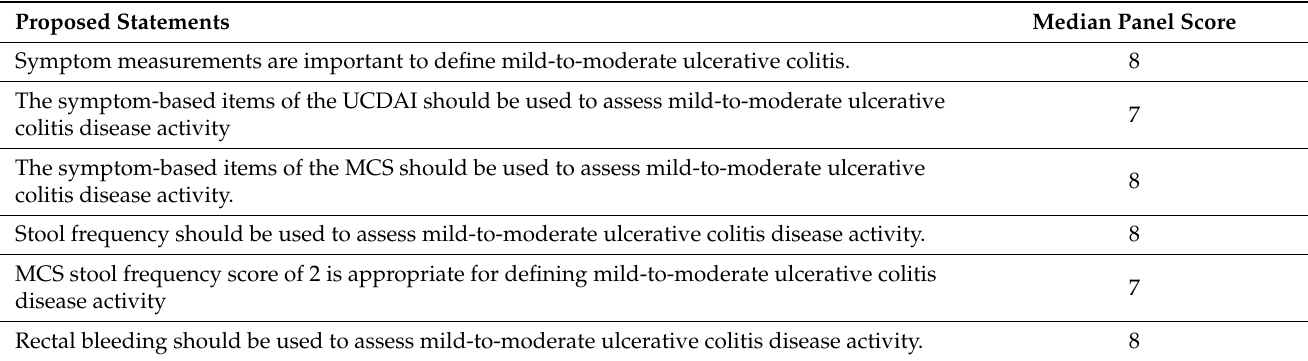
Table 1. Approved statements for definition of mild-to-moderate ulcerative colitis for inclusion in clinical